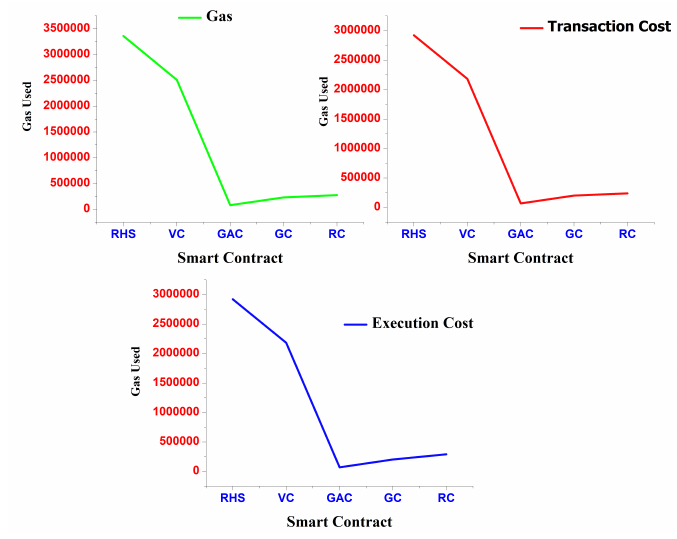
Figure 4. Smart contract using GAS, transaction and execution